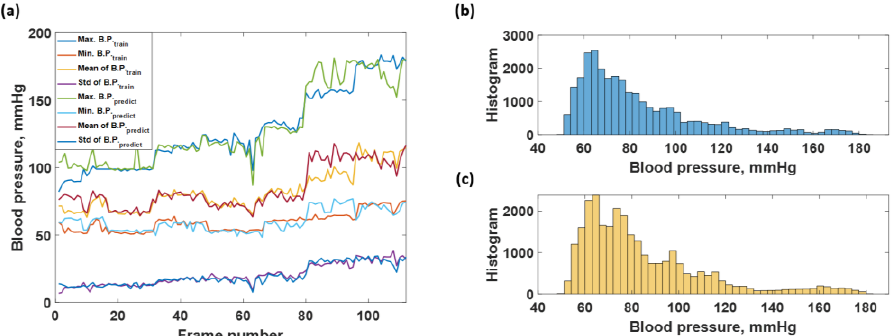
Figure 14. Shows the ( a ) average max, min, mean, and standard deviation of each frame number for test dataset and predicted responses; ( b ) histogram of blood pressure level covering in the actual testing blood pressure data; and ( c ) histogram of blood pressure level covering in the predicted blood pressure data by using LSTM network. Table 6. The performance comparison between the CAN with the proposed preprocessing method and the LSTM without the preprocessing method. RMSEs for the Resubstitution Performance LSTM without the RMSE CAN with the Preprocessing The standard deviation LSTM without the Prepro- RMSEs for the Test Dataset Responses RMSE CAN with the Preprocessing LSTM without the RMSE CAN with the Preprocessing The average minimum B.P